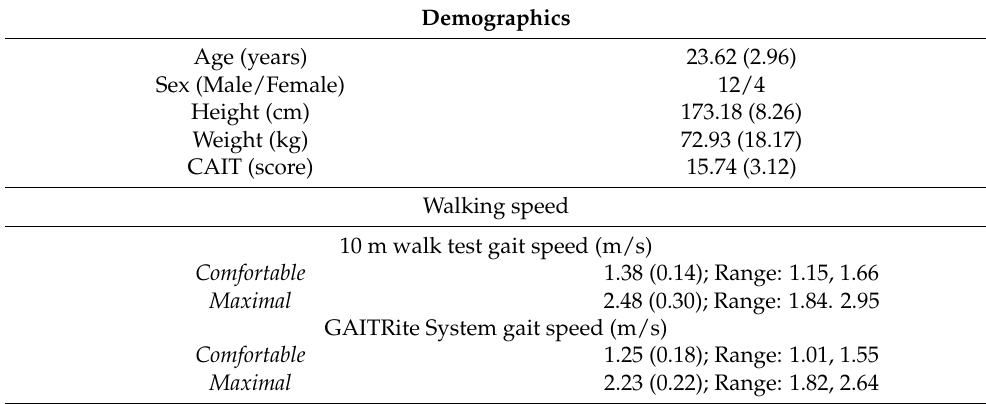
Table 1. Demographics and gait speed of measurement